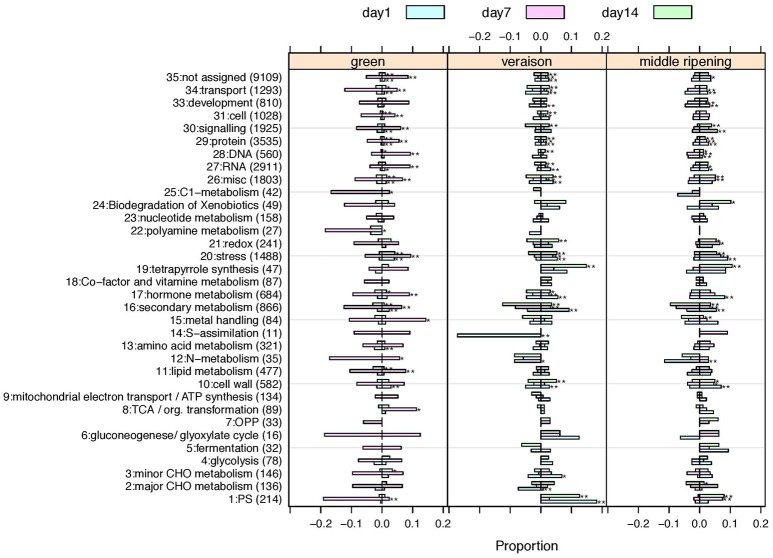
Proportions of up- or down-regulated genes for each MapMan main category. One panel per developmental stage is presented. Treatment durations are colored. Overproportionally affected categories based on a Chi-square test are marked by asterisks (*p < 0.01; **p < 0.001.). Category number (BIN), description and the total number of associated genes are given on the y-axis. Negative values on the x-axis indicate the proportion of down-regulated genes, positive values the proportion of up-regulated genes. A tabular view also indicating the number of significantly impacted conditions per category and the number of up- or down-regulated genes is given in Supplementary Table 5.